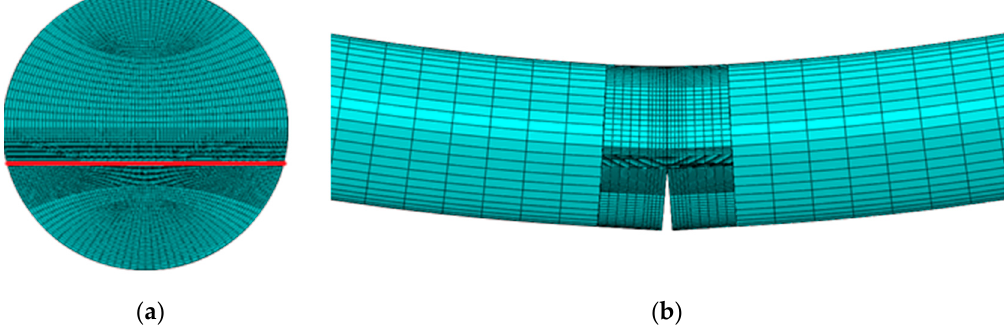
Figure 4. Mesh 9—the chosen mesh showing ( a ) radial and ( b ) axial refinement, particularly local to the crack.